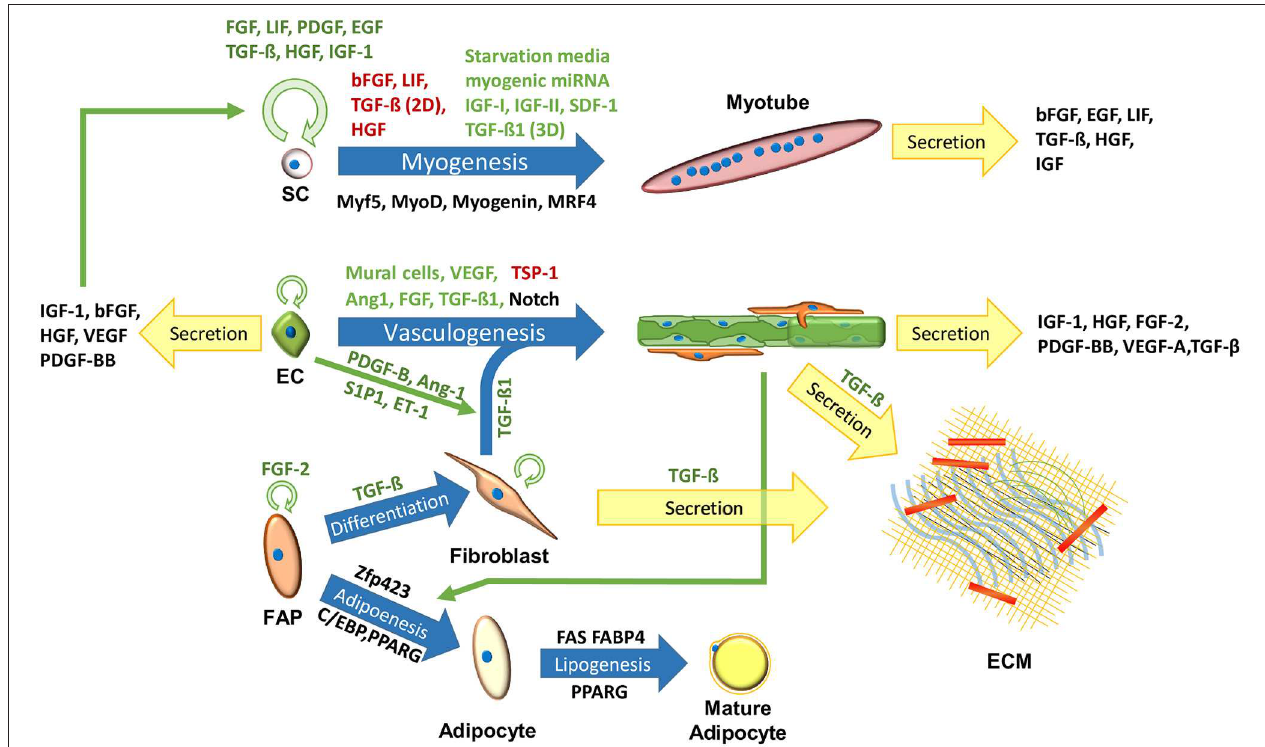
FIGURE 1 | Cells in the skeletal muscle niche. Blue arrows signify maturation processes. Black, green, and red text next to the arrows signify key biomarkers, inhibitors and enhancers of the process, respectively. Circular green arrows signify cell proliferation.